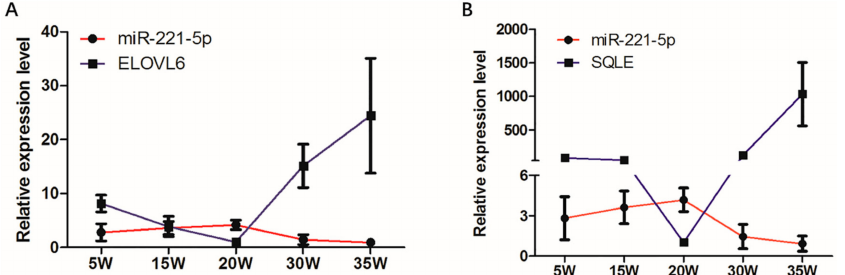
Figure 4. Expression of gga-miR-221-5p and candidate target genes in di ff erent liver stages. ( A ) Expression of gga-miR-221-5p and ELOVL6 in di ff erent liver stages. ( B ) Expression of gga-miR-221-5p and SQLE in di ff erent liver stages. β -actin was used as an internal reference gene to estimate the relative expression of mRNA. U6 was used as an internal reference gene to estimate the relative expression of miRNA. Data are represented as mean ± SD ( n =